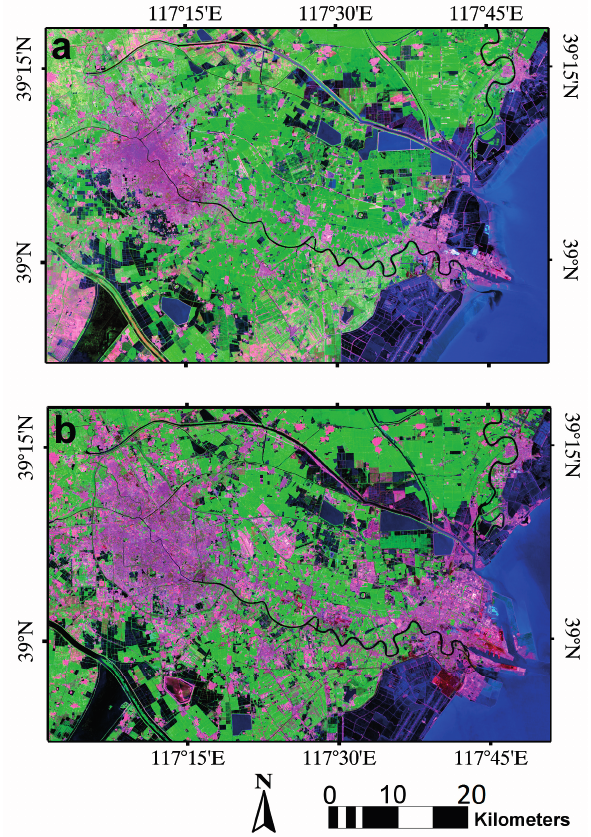
Figure 3. Landsat TM image of the Tianjin urban area (7, 4 and 2 bands as R, G and B) acquired in 1992 ( a ) and 2006 ( b